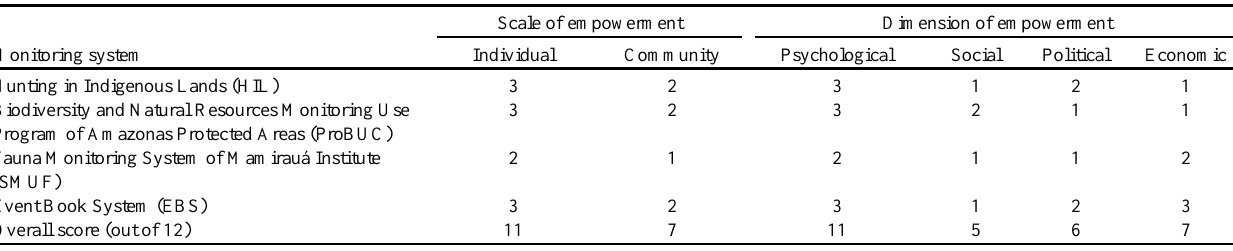
Table 3. Scales and dimensions of local empowerment promoted through the use of monitoring systems in Brazilian Amazonia and Namibia. Numbers represent the authors’ evaluation of local empowerment using a four-point scale, with 3 the highest and 0 the lowest degree of